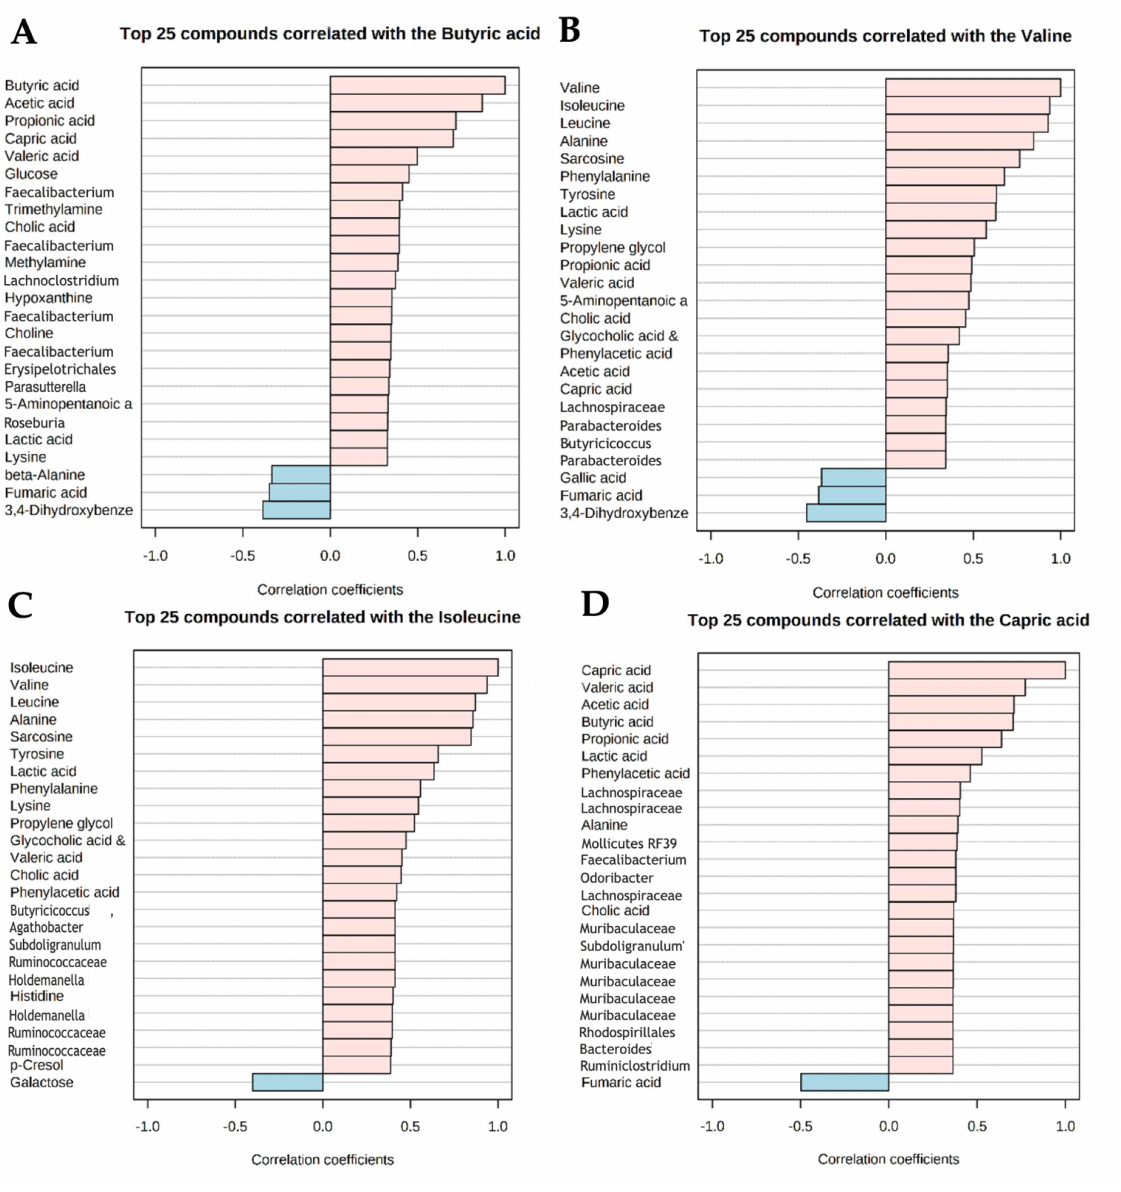
Figure 7. Top 25 correlations with the normalized concentrations of ( A ) valine, ( B ) butyric acid, ( C ) capric acid, ( D ) isoleucine, and 16S rRNA microbiome analysis data and the normalized concen- trations of quantitatively assessed metabolites by